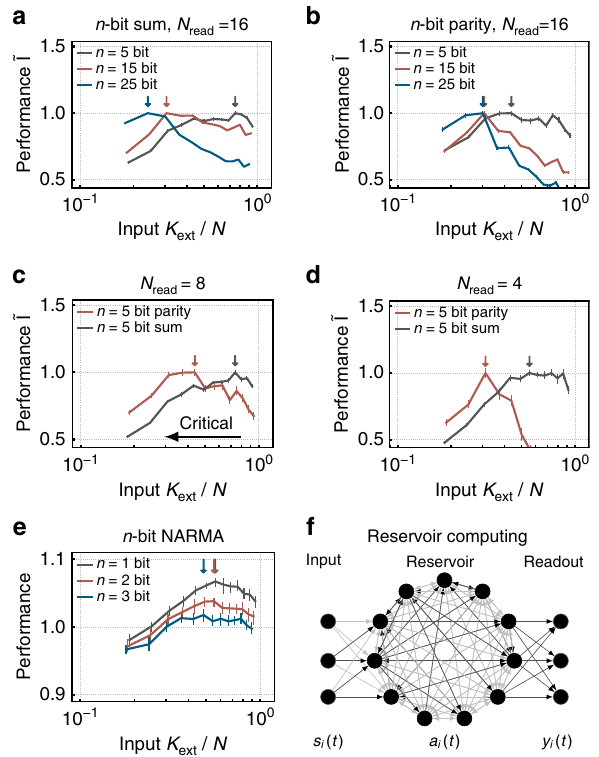
Fig. 5 Computational challenging tasks pro fi t from critical network dynamics (small K ext ) — simple tasks do not. The network is used to solve ( a ) a n -bit sum and ( b ) a n -bit parity task by training a linear classi fi er on the activity of N read = 16 neurons. Here, task complexity increases with n , the number of past inputs that need to be memorized and processed. For high n , task performance pro fi ts from criticality, whereas simple tasks suffer from criticality. Especially, the more complex, nonlinear parity tasks pro fi ts from criticality. Further, task complexity can be increased by restricting the classi fi er to c N read = 8 and d N read = 4. Again, the parity task increasingly pro fi ts from criticality with decreasing N read . The performance is quanti fi ed by the normalized mutual information ~ I between the vote of the classi fi er and the parity or sum of the input. e Likewise, the peak performance moves toward criticality with increasing complexity in a NARMA task. The performance is quanti fi ed by the inverse NRMSE. Highest performance for a given task is highlighted by colored arrows. f Schematic reservoir computing